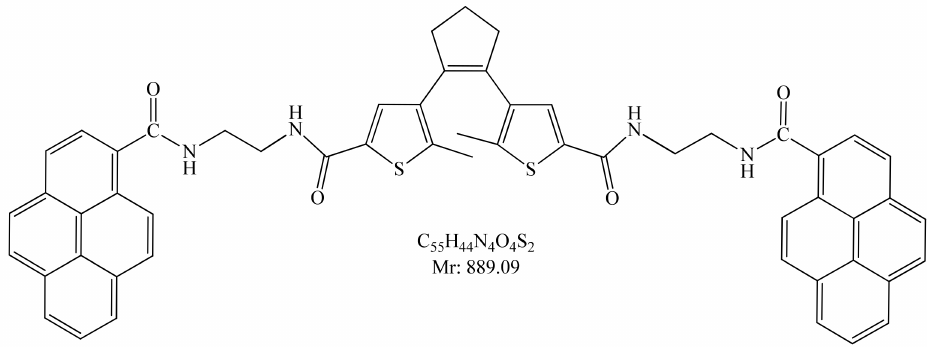
Figure 17. 4,4 (cid:48) -(cyclopent-1-ene-1,2-diyl)bis(5-methyl-N-(2-(pyrene-1-carboxamido)ethyl)thiophene- 2-carboxamide)